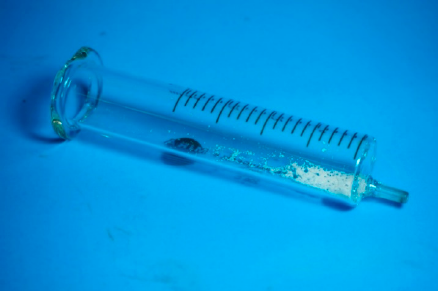
Figure 6. The remaining NaCl in the glass syringe after melt-electrospinning.